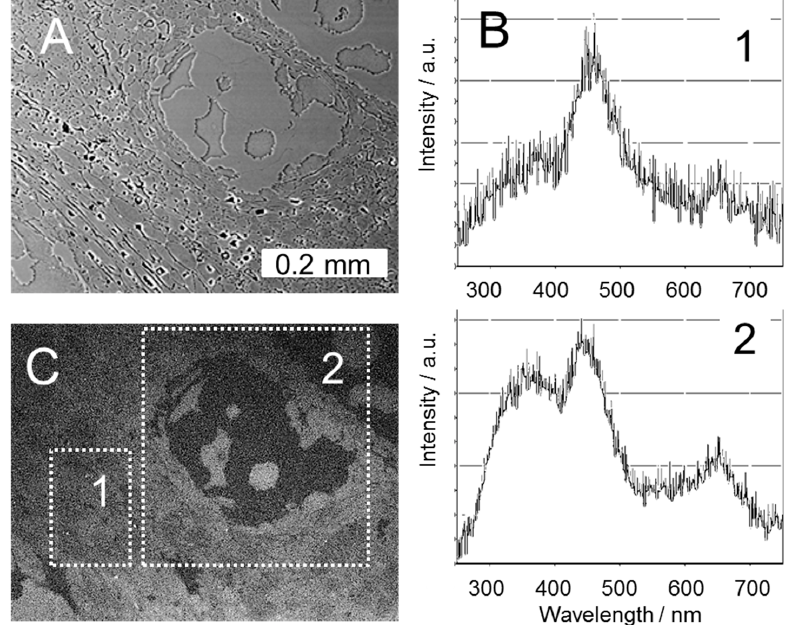
Figure 15. SEM-CL emerging from opalized tissue surrounding an early wood vessel (transverse plane). ( A ) SEM BSE image; ( B ) CL spectra for regions 1 and 2 marked in ( C ) panchromatic SEM-CL image.